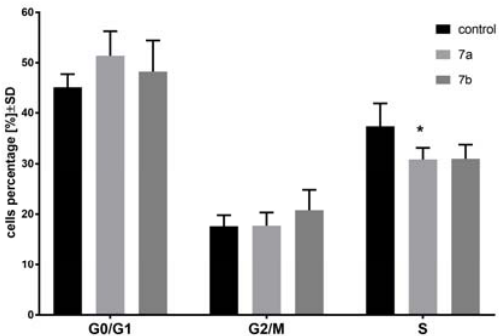
Figure 1. Cell cycle analysis of MV4-11 cells after treatment of 1-anisoyl-2-hydroxy- sn -glycero-3- phosphocholine ( 7a ; 30 µm) and 1-veratroyl-2-hydroxy- sn -glycero-3-phosphocholine ( 7b ; 15 µm); * p < 0.05 in comparison to control cells, t -test, Statistica v.10.